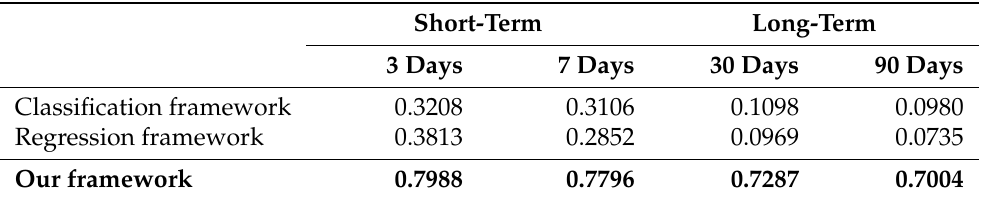
Table 6. Comparison of the F1 score in discontinuation prediction after N days using the binary classification framework and regression